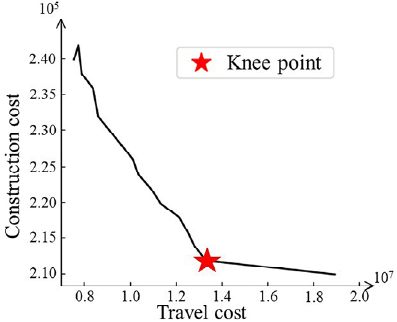
Figure 7. Geometric expression of the knee point of Nanyuan.